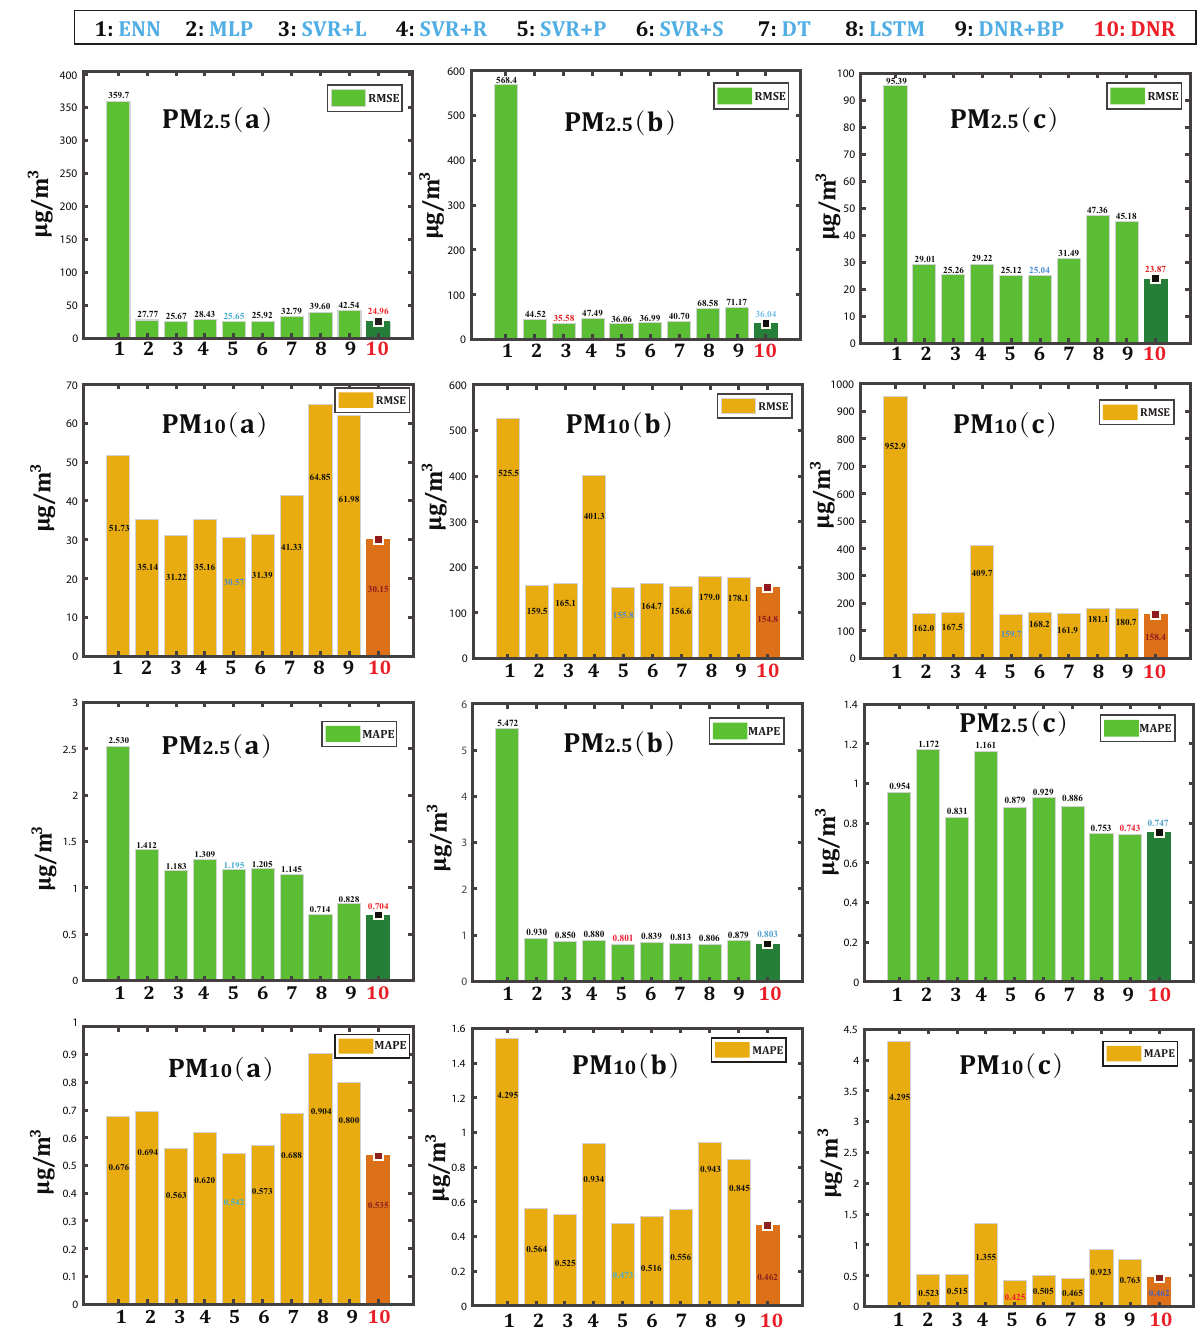
Figure 6. Comparison of the RMSE and MAPE of the estimation models based on six